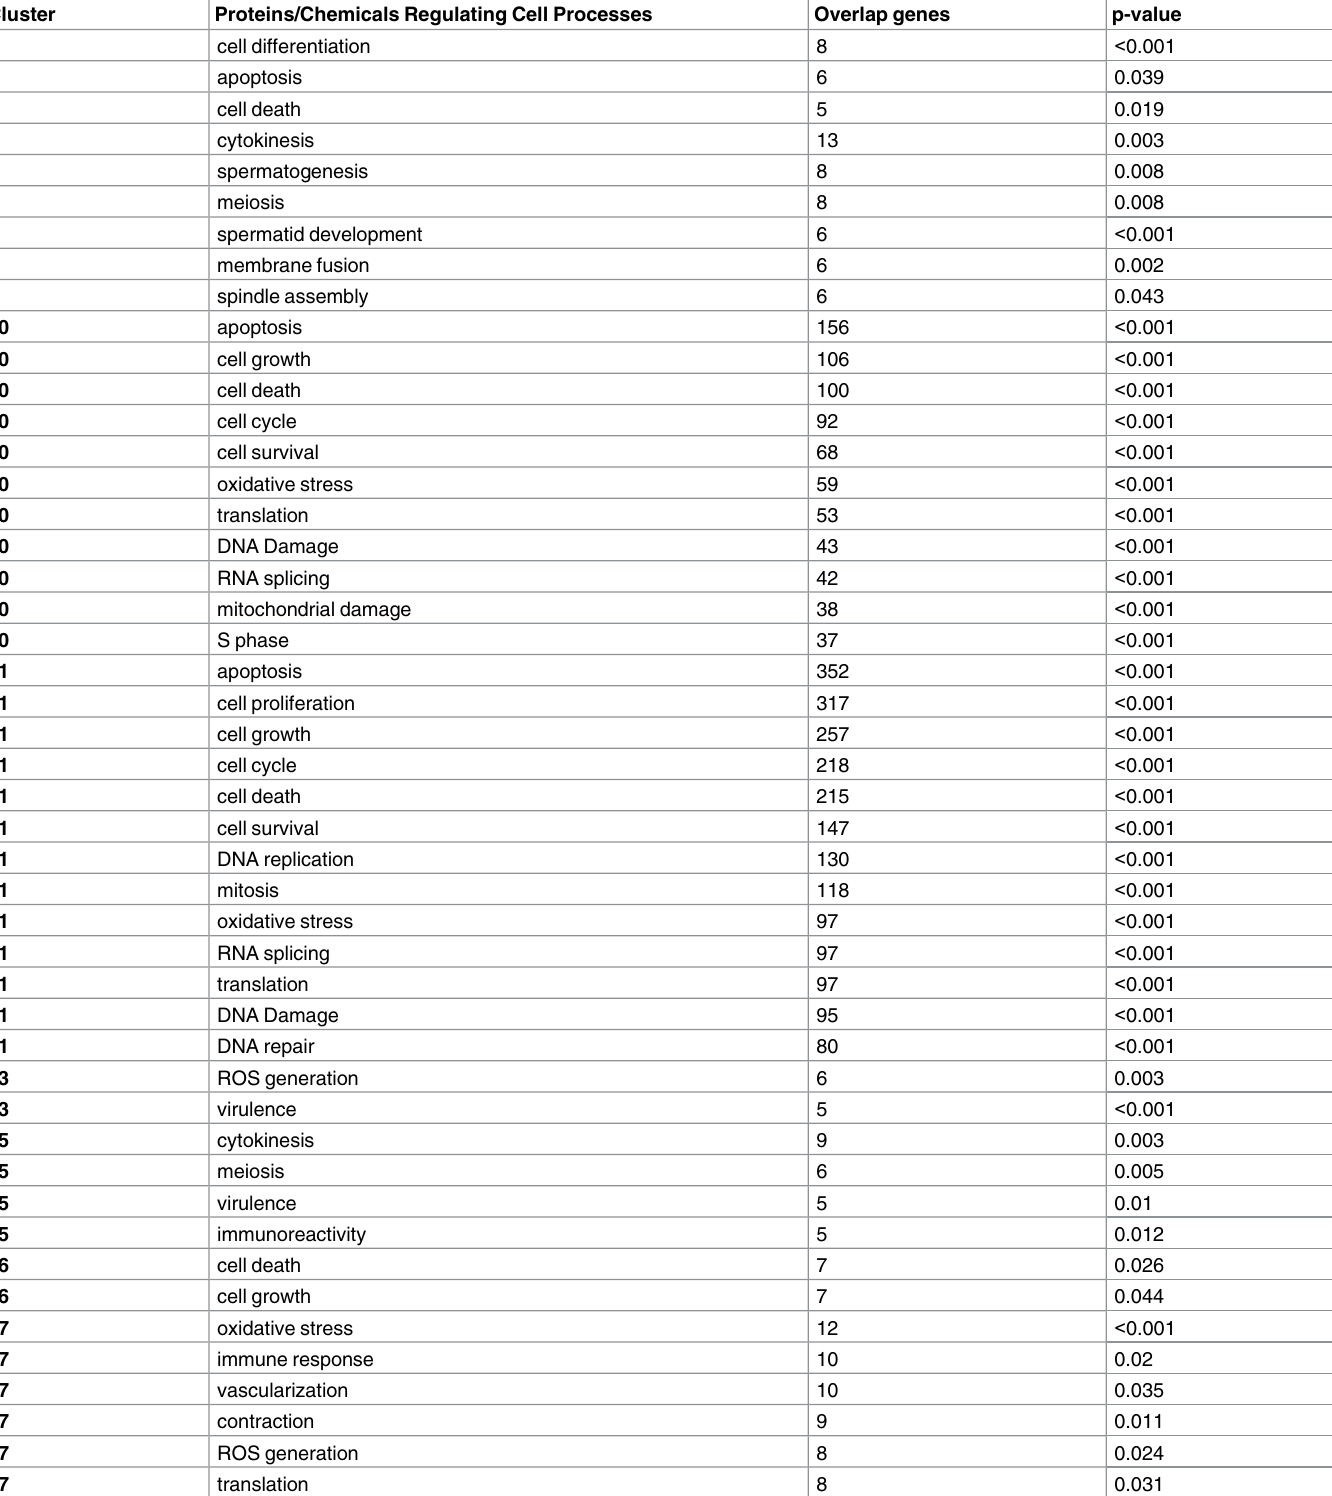
Table 2. Sub-Network enrichment analysis (SNEA) of the proteins/chemical cell processesinvolved in each